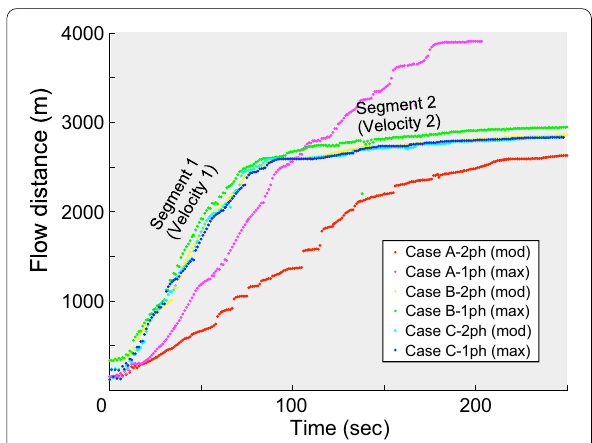
Fig. 14 Simulated travel distances of Scenario A, B and C, showing a breakpoint in flow velocity at around 2500 m distance. The velocity is estimated by distance between the flow front and the starting point without consideration of sinuosity of the rivers and valleys